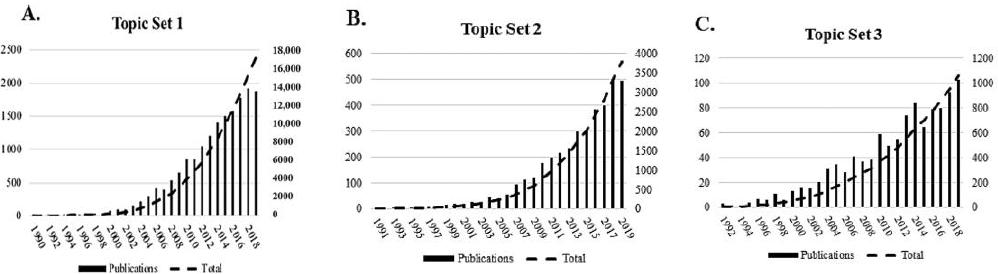
Figure 1. Number of publications and cumulative number of publications for topic set 1( A ), topic set 2( B ) and topic set 3( C ) per